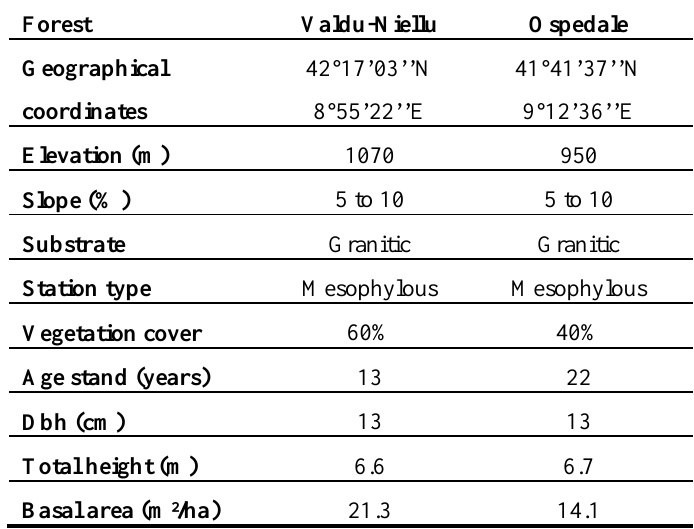
Table 2. General characteristics of study sites and Pinus laricio stands (mean per site); Dbh: Diameter at breast height).